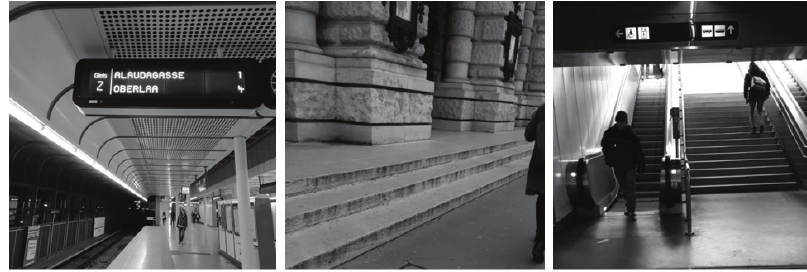
Figure 3. Examples of mobilities in the visual diaries of